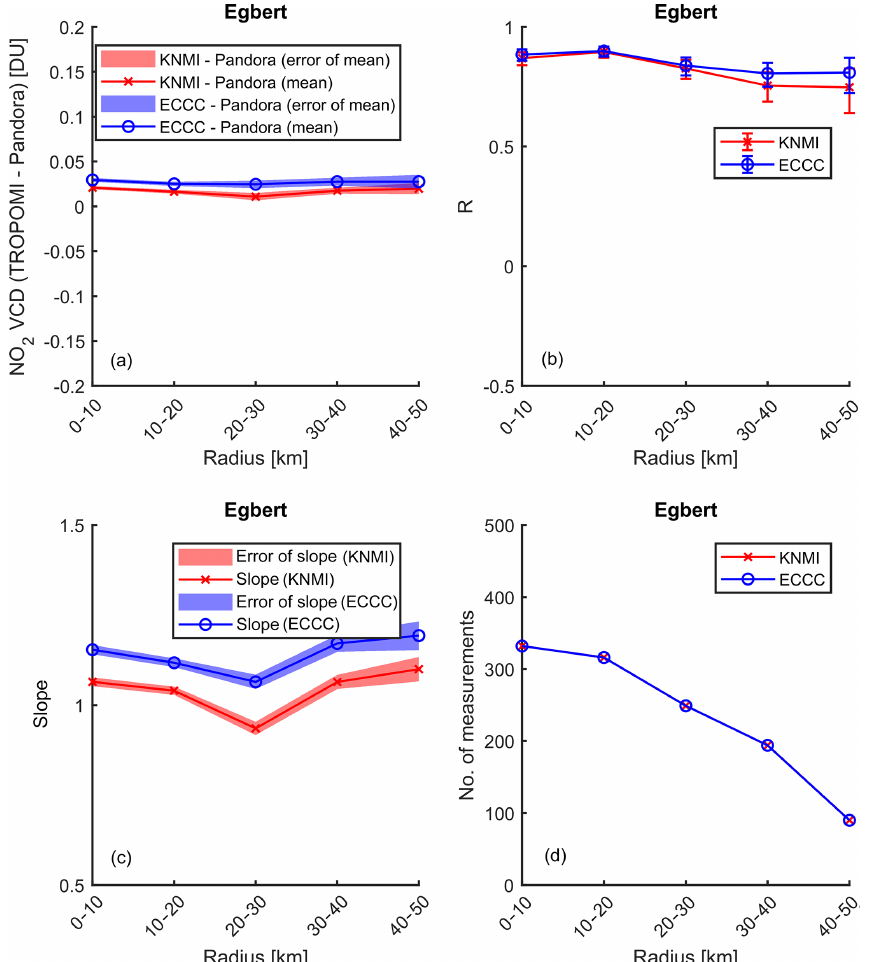
Figure B3. Sensitivity test for Pandora no. 108 at Egbert. Descriptions of the legend in Fig.